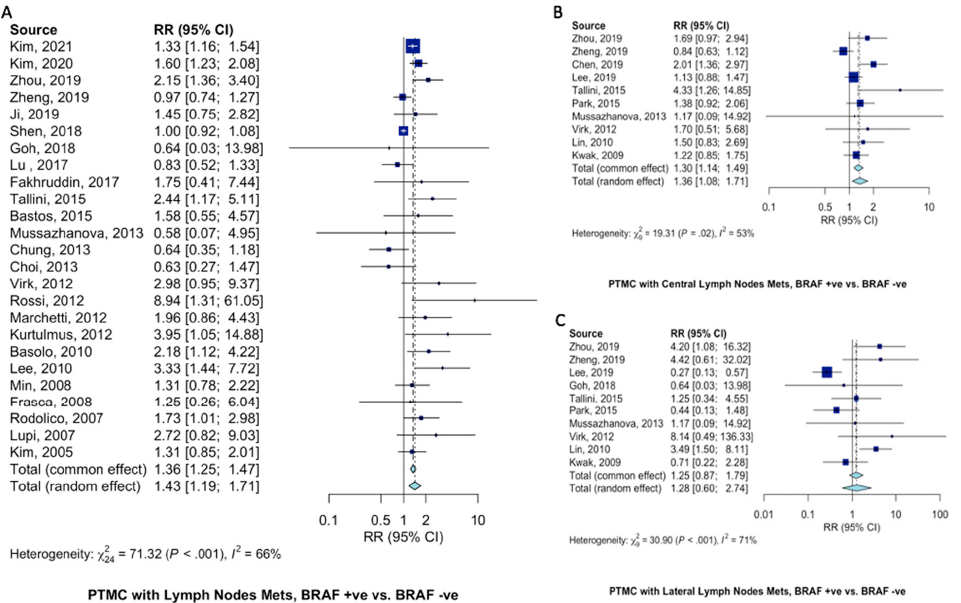
Figure 4. Pooled analysis of lymph node metastasis in PTMC patients according to BRAF V600E mutation. Forest plots for ( A ) LNM [10–13,15,18–22,24,27–33,35,36,38–42], ( B ) central LNM [12–14,16,22,23,27,30,34,37], and ( C ) lateral LNM [12,13,16,19,22,23,27,30,34,37]. Patients with BRAF V600E -mutant PTMC at 61% (RR = 1.61, 95%CI = 1.14–2.28, Figure 5A) increased risk of presenting with advanced (TNM > 3) clinical stage. Risk of capsular invasion were similar (RR = 1.19, 95%CI = 0.90–1.57, Figure 5B) between PTMC patients with and without BRAF V600E mutation. Disease recurrence was almost twice as likely in patients with BRAF V600E -mutant PTMC (RR = 1.90, 95%CI = 1.43–2.53, Figure 5C) than those not harboring BRAF V600E mutation.